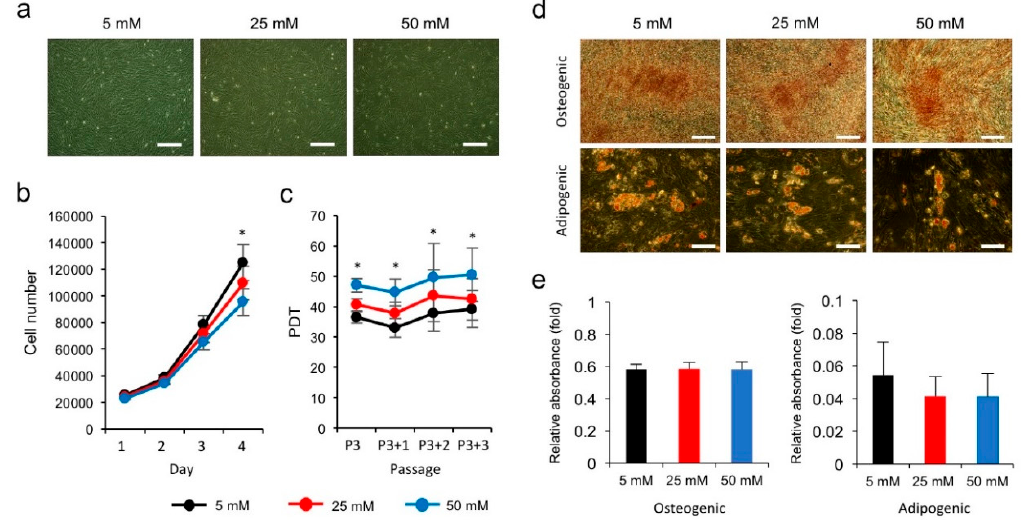
Figure 1. Effects of high glucose on the proliferation and differentiation of human perivascular cells (hPVCs). ( a ) Representative images of hPVCs cultured under normal (5 mM) and hyperglycemic (25 and 50 mM) conditions. Scale bars, 100 µ m. ( b ) Growth curve assay of hPVCs cultured under normal glucose (NG) (5 mM) and high glucose (HG) (25 and 50 mM) for 4 days. hPVCs were seeded at a density of 4 × 10 4 cells per well and counted at 1 to 4 days after culture at each condition. ( c ) PDT was determined from passage 3 (P3) to P6. ( d ) Representative images of Alizarin Red S staining for osteocytes and Oil Red O staining for adipocytes. Scale bars, 100 µ m. ( e ) Measurements of Alizarin Red S and Oil Red O contents using spectrophotometry. Bars indicate mean ± SD. * p < 0.05.